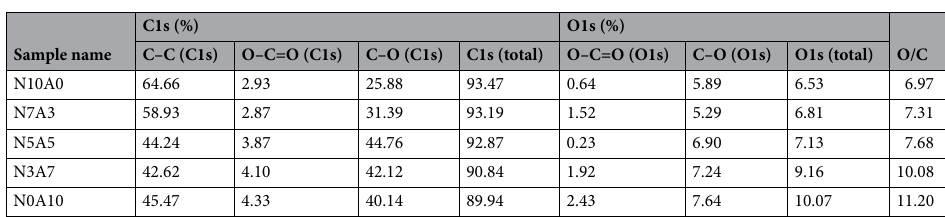
Table 2. Atomic % of C1s and O1s from